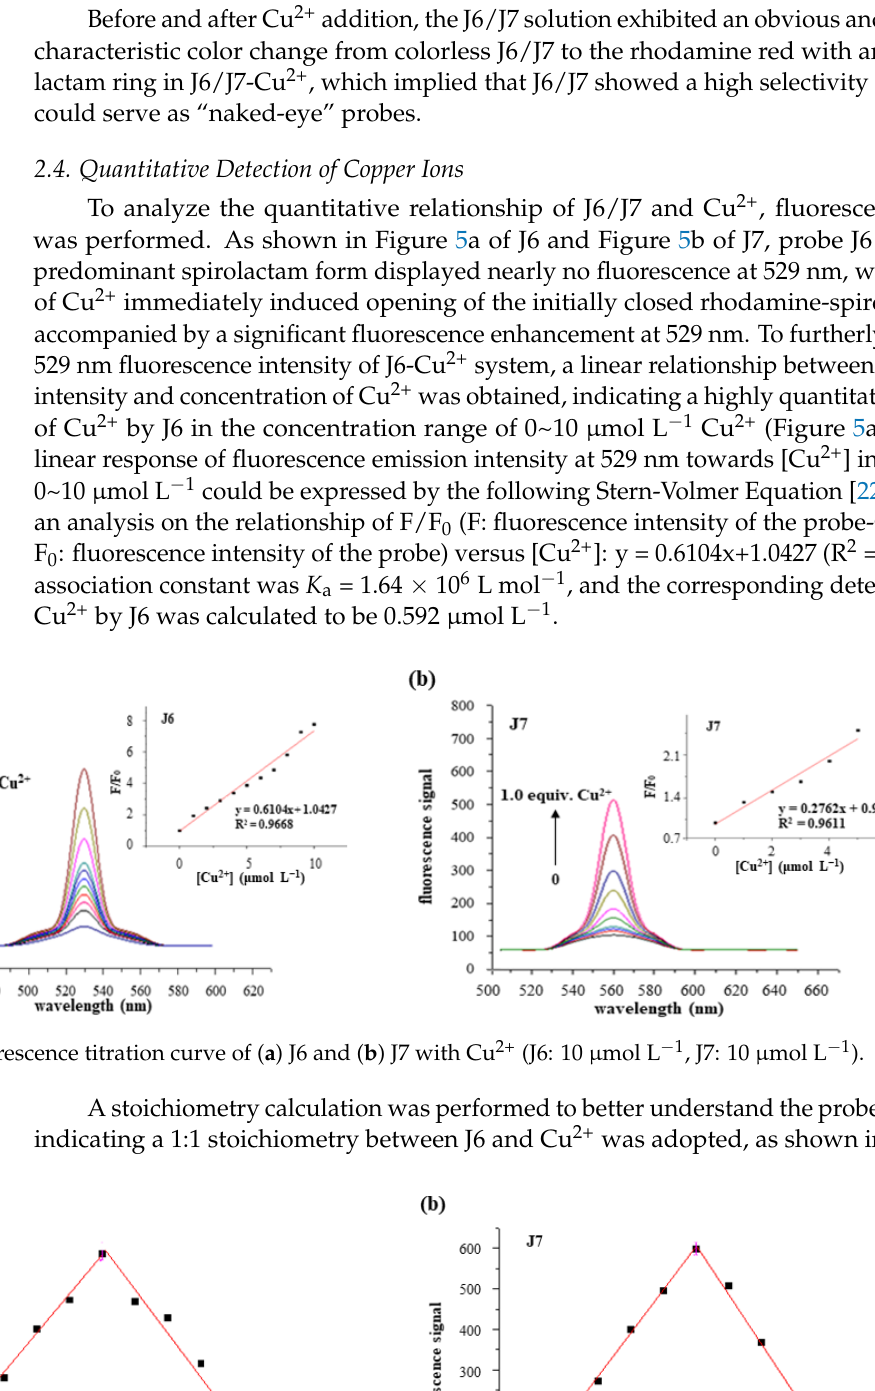
Figure 4. Visible color changes of J6 (top) and J7 (bottom) after the addition of Cu 2+ .